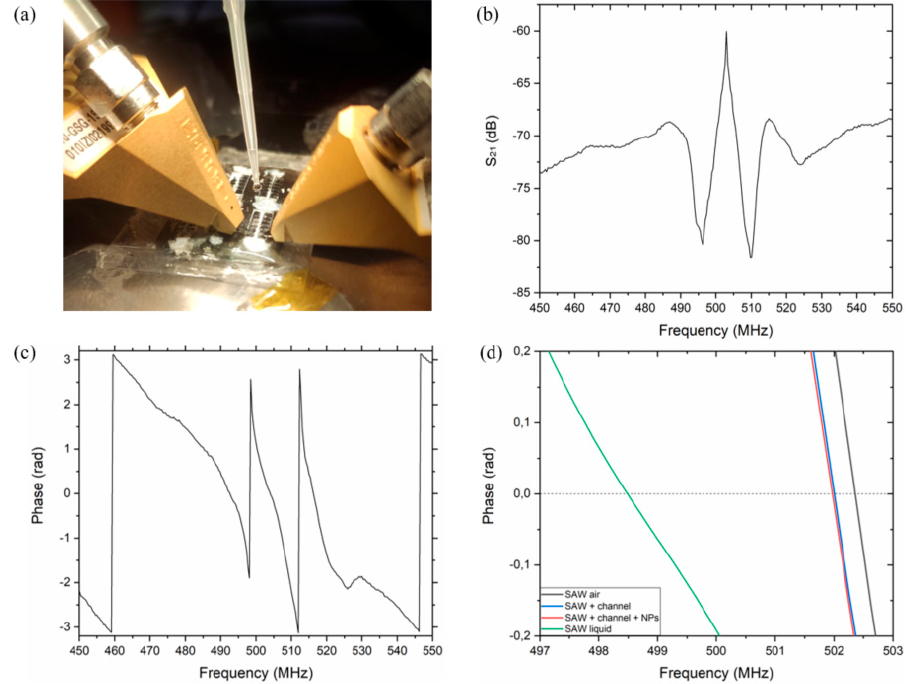
Figure 8. Experimental setup, used to study the electroacoustic response of the SAW devices ( a ), transfer function amplitude S 21 of the PEN device in air ( b ) and its phase response in air ( c ); changes in phase response of SAW device in air, after microchannel fabrication, after NPs deposition and the microchannel was filled with liquid ( d ).